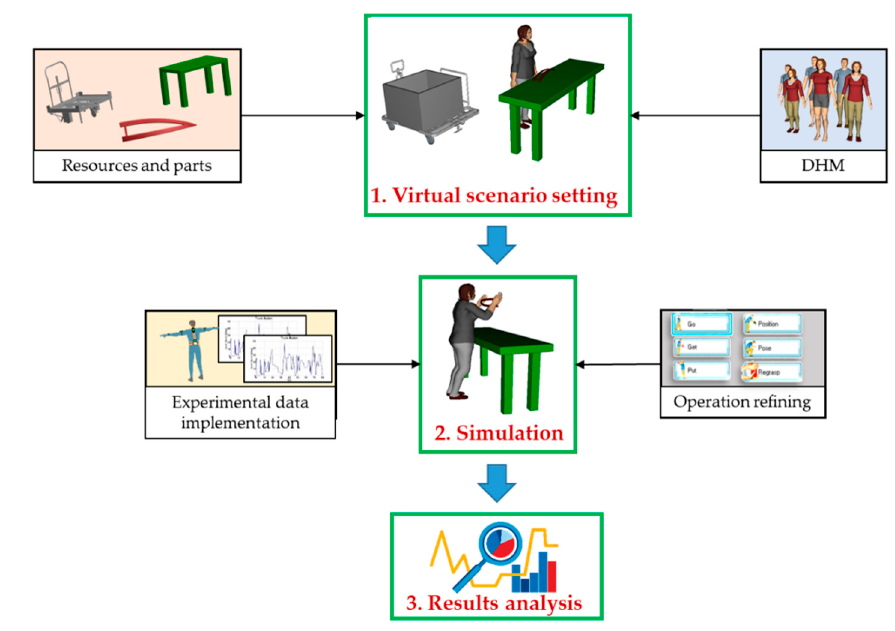
Figure 2. Procedure for realizing the simulation of the investigated working activity.